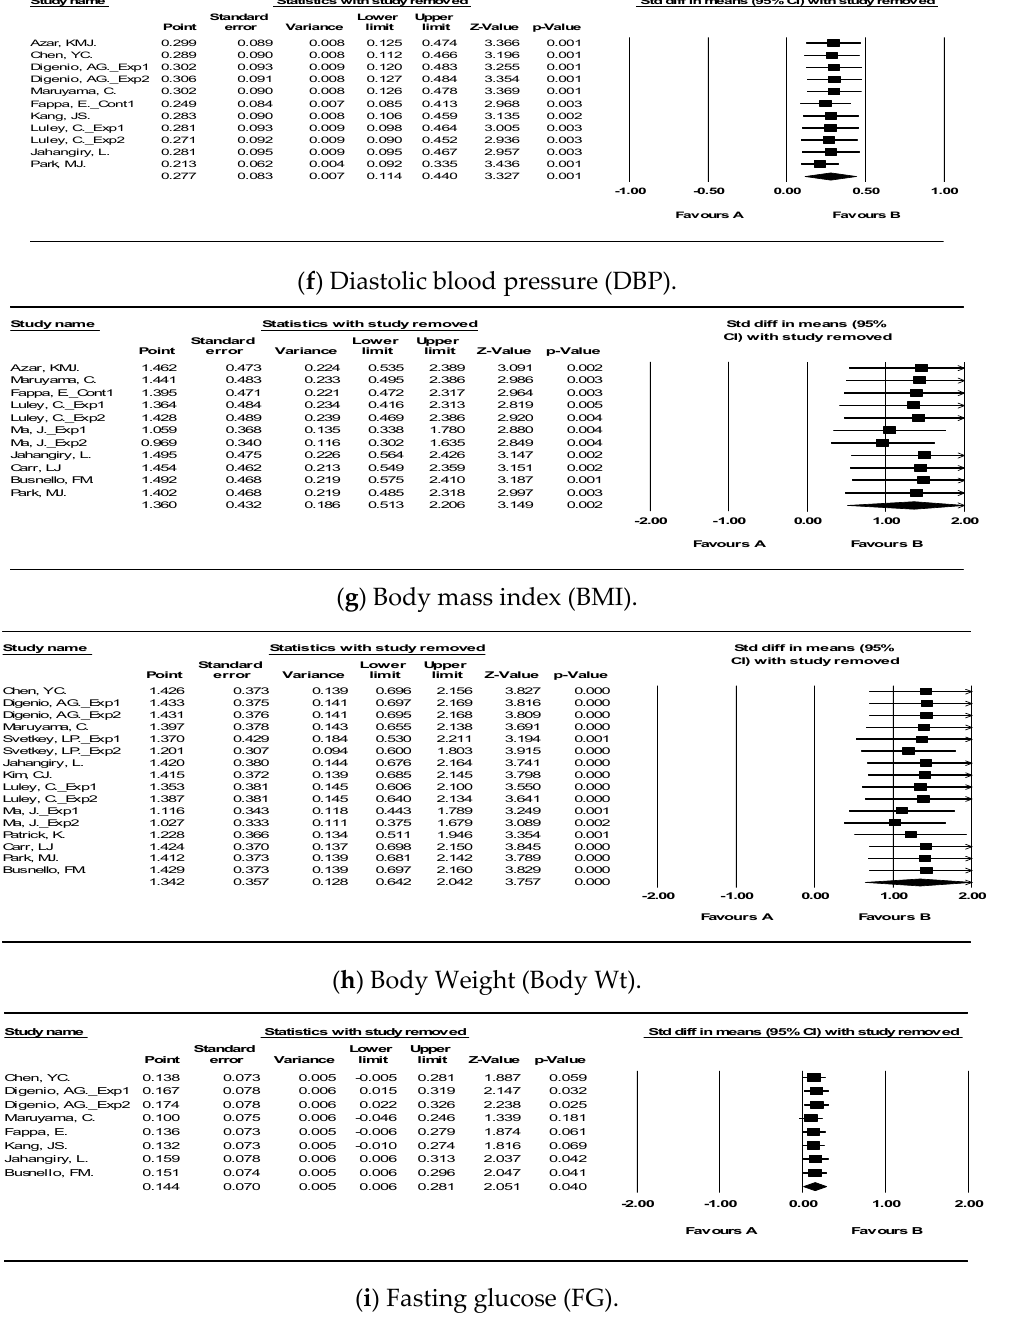
Figure 5. Forest plot after sensitivity analyses of the meta-analysis for the technology-mediated MetS intervention. ( a ) Waist circumference (WC), ( b ) High-density lipoprotein cholesterol (HDL), ( c ) Low-density lipoprotein cholesterol (LDL), ( d ) Triglycerides (TG), ( e ) Systolic blood pressure (SBP), ( f ) Diastolic blood pressure (DBP), ( g ) Body mass index (BMI), ( h ) Body weight (Body Wt), ( i ) Fasting glucose (FG).